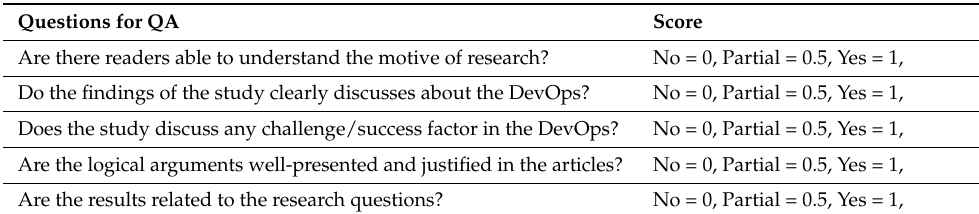
Table 2. Quality assessment